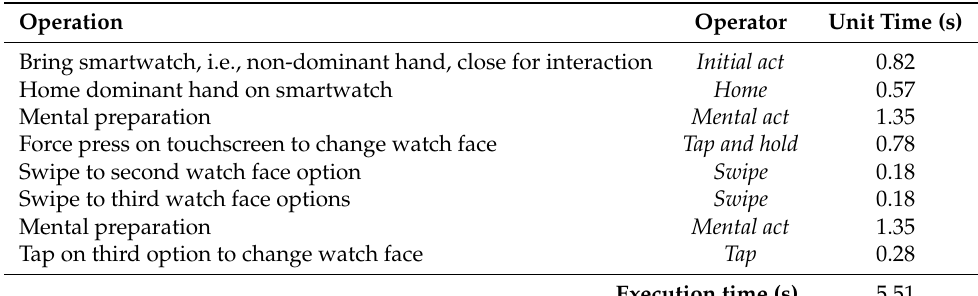
Table 6. Modelled sequence of operations for Apple Watch task 1 using the revised KLM for smartwatch